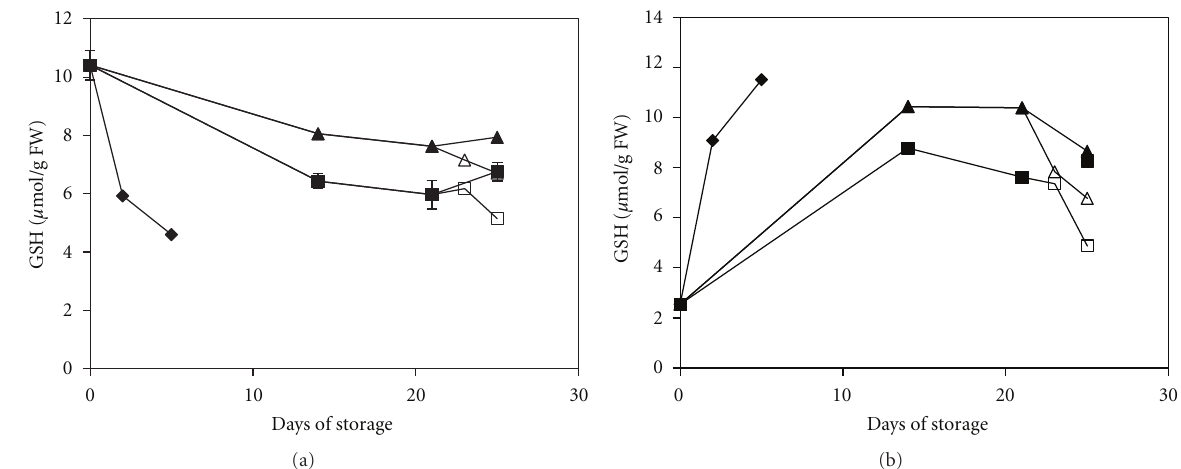
Figure 3: Changes in the GSH content of mature green peppers (a) and fully ripe/red peppers (b) for the UCRT ( (cid:2) ), MAP ( (cid:3) ), and MAP+1- MCP ( (cid:4) ) treatments during storage at 10 ◦ C; MAP ( (cid:5) ) and MAP+1-MCP ( (cid:6) ) values for the fruits transferred to room temperature at day 21. The values are the means of six replicate samples, and their S.E.s are